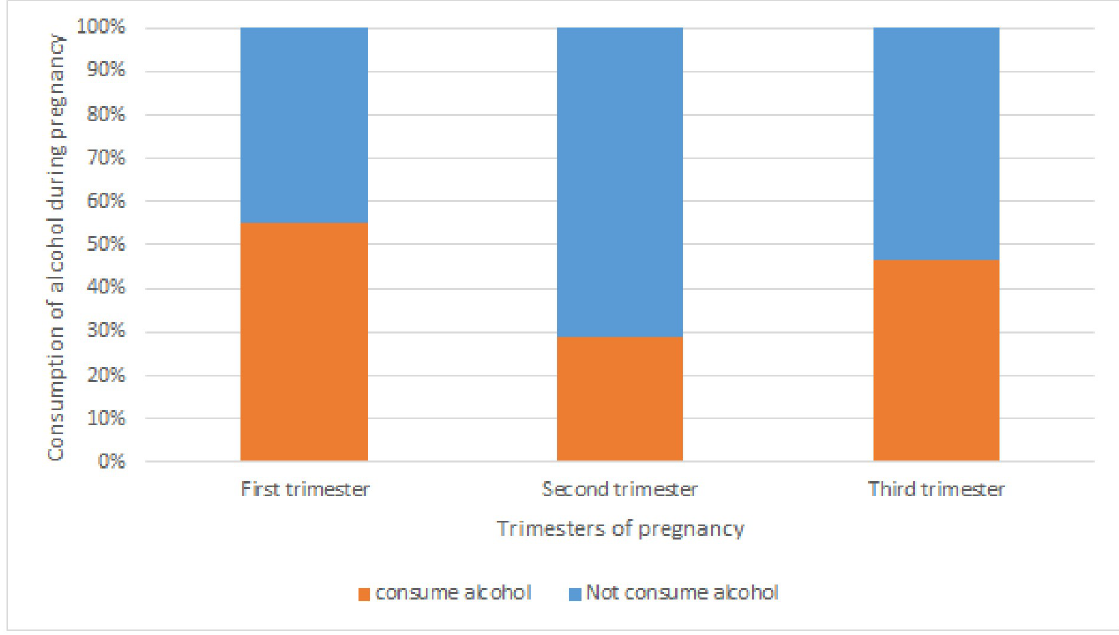
Fig 1. Alcohol consumption among pregnant women respected to trimesters of pregnancy in Kolfe Keranio sub city (n = 367), Addis Ababa, Ethiopia.